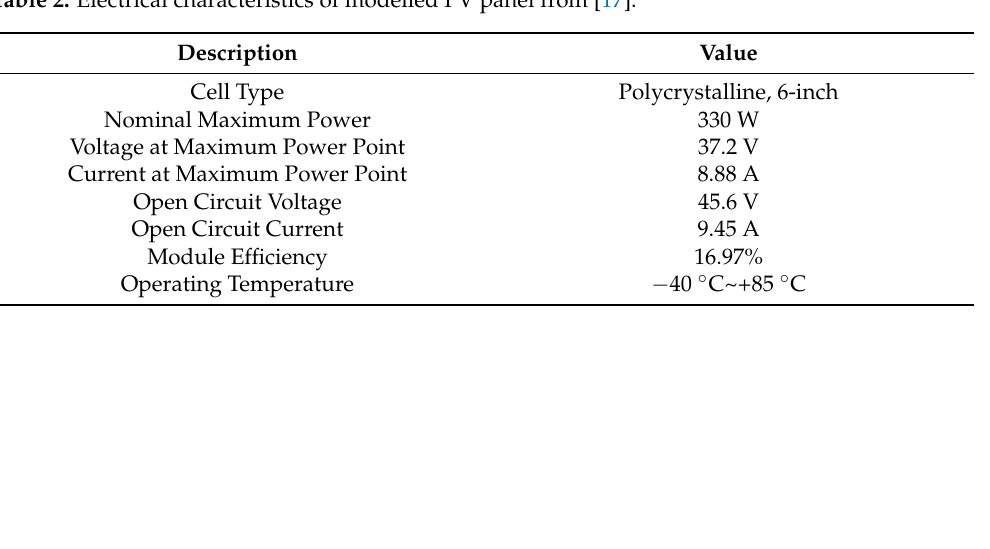
Table 2. Electrical characteristics of modelled PV panel from